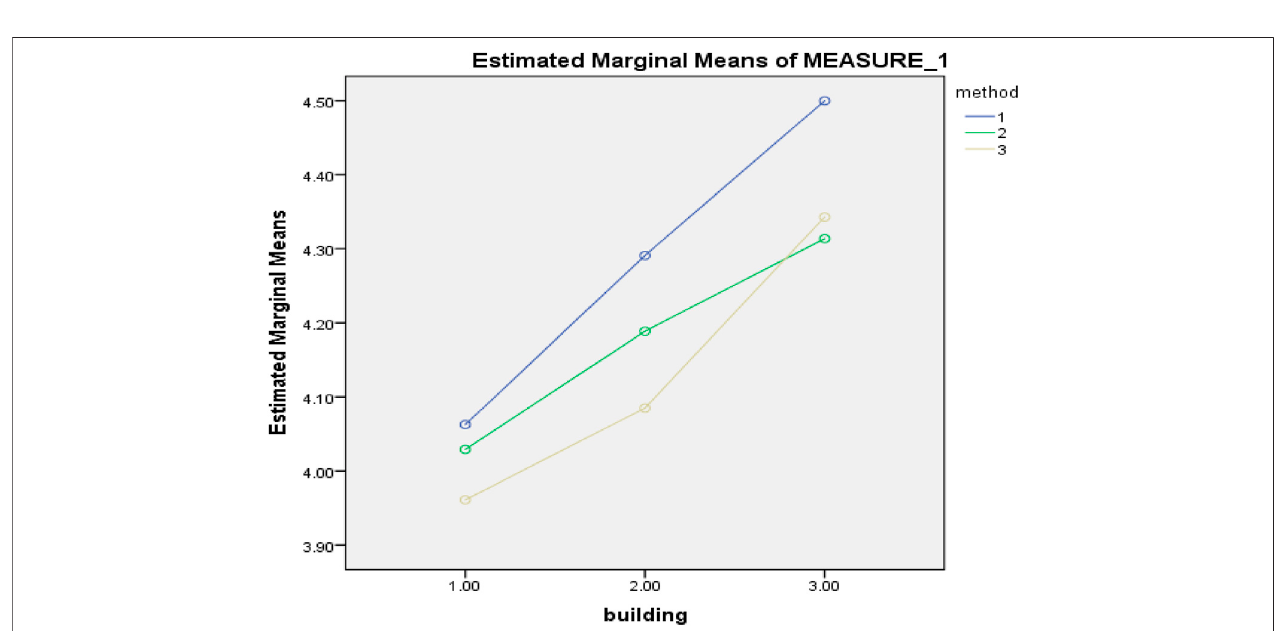
FIGURE 5 | Comparing the effects of methods on three types of buildings.